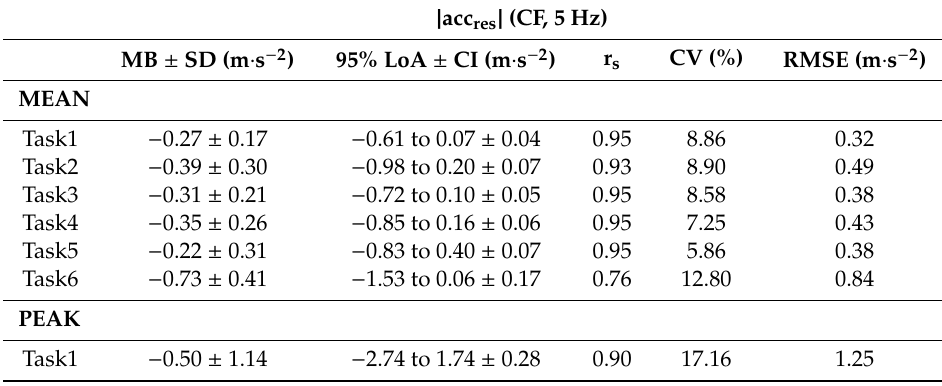
Table 2. Analysis of agreement between CF data and MA system data for each movement task. Outcomes for mean and peak values are presented at a temporal resolution of 5 Hz and refer to | acc res | only. MB, mean bias; SD, standard deviation; 95% LoA, 95% limits of agreement; CI, confidence